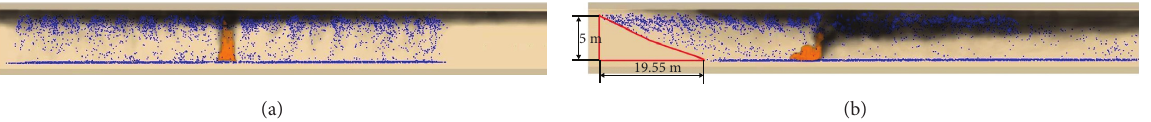
Figure 7: Trajectory of water mist droplets in the tunnel. (a) No longitudinal shift. (b) Downstream shift.